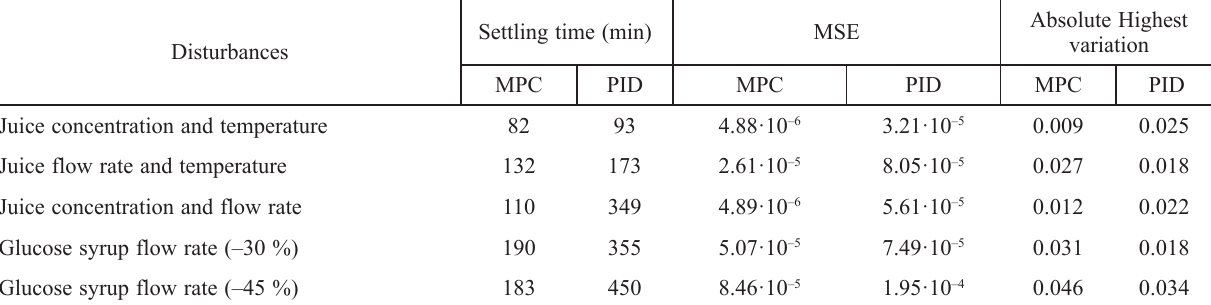
Fig. 7 – Manipulated valve opening and steam inlet flow rate fed to the first effect when simultaneous disturbances in juice sugar concentration and temperature (a), juice volumetric flow rate and temperature (b), and juice sugar concentration and volumetric flow rate (c) are applied Table 1 – Control metrics related to the response of MPC and PID controllers to different disturbances. The controlled variable is the concentration of the concentrated juice that leaves the system, and the manipulated variable is the flow rate of steam fed to the first